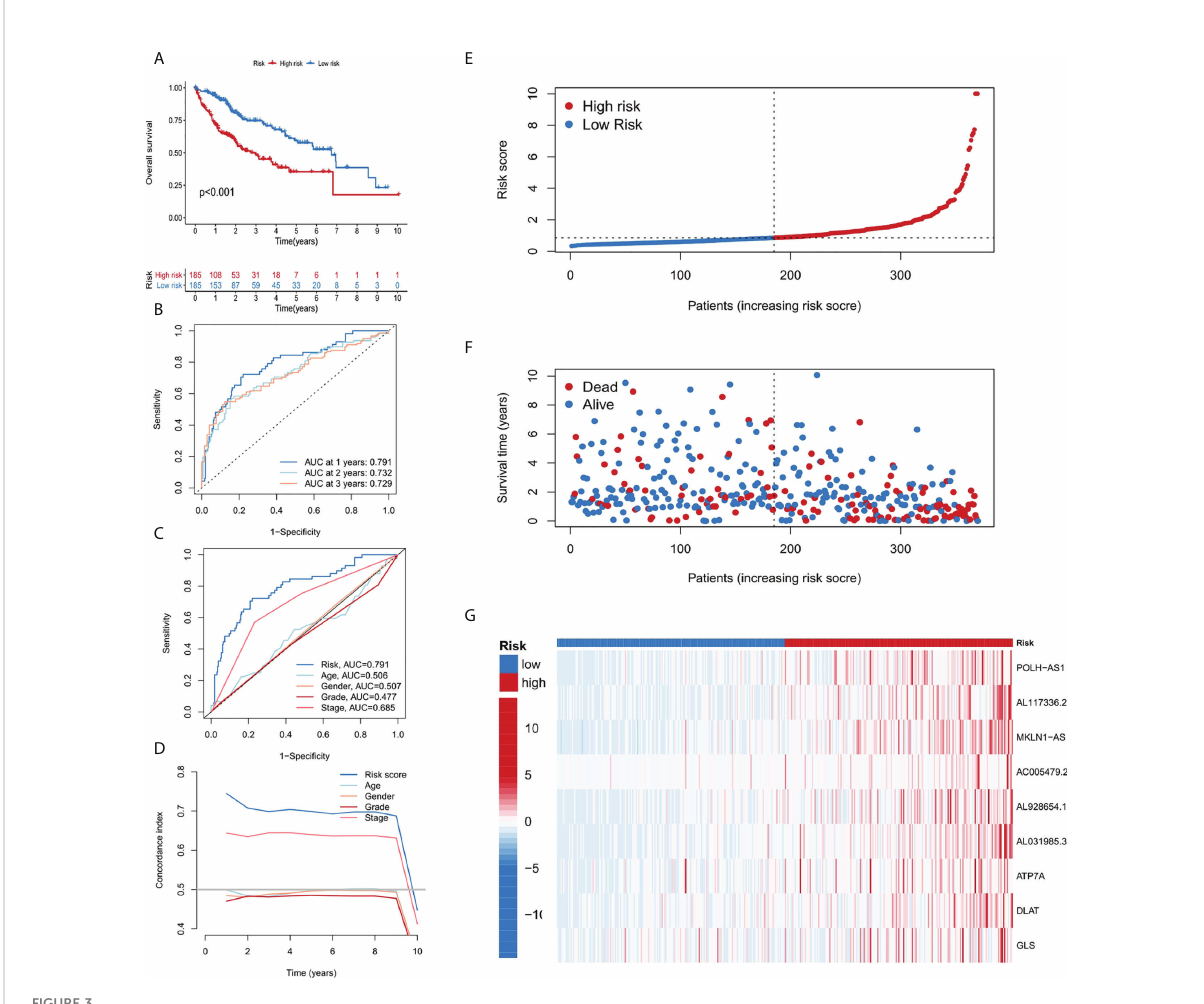
FIGURE 3 Establishment and evaluation of the 9-gene signature. (A) Kaplan-Meier survival analysis of liver cancer patients in the high-risk and low-risk groups. (B) Time dependent ROC curves of overall survival at 1, 2- and 3- years. (C) ROC curves of risk score for clinical features in liver cancer patients. (D) The C-index curve analyzes the consistency index of risk score. (E – G) The distribution of risk score, survival status, and 9-gene expression pro fi les for each liver cancer